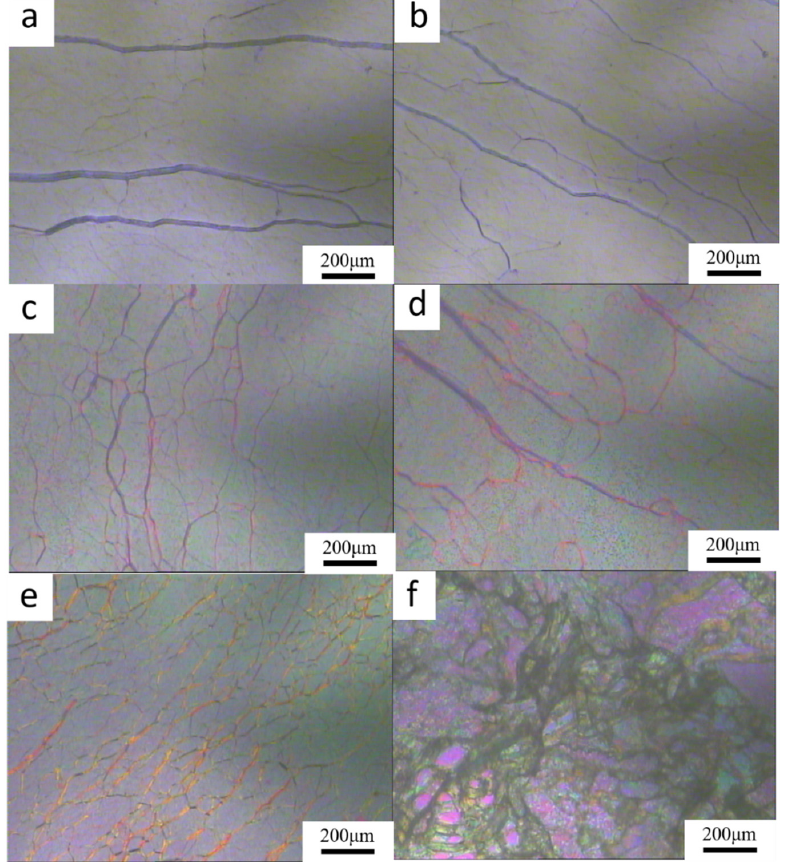
Figure 6. The crossed polarizing images of each layer of PSCLC film before and after stripping the upper substrate were as follows: ( a , b ) before and after the first layer of PSCLC film was removed from the substrate; ( c , d ) before and after the second layer of PSCLC film was removed from the substrate; ( e , f ) the PSCLC film before and after the stripping of ordinary glass substrate.